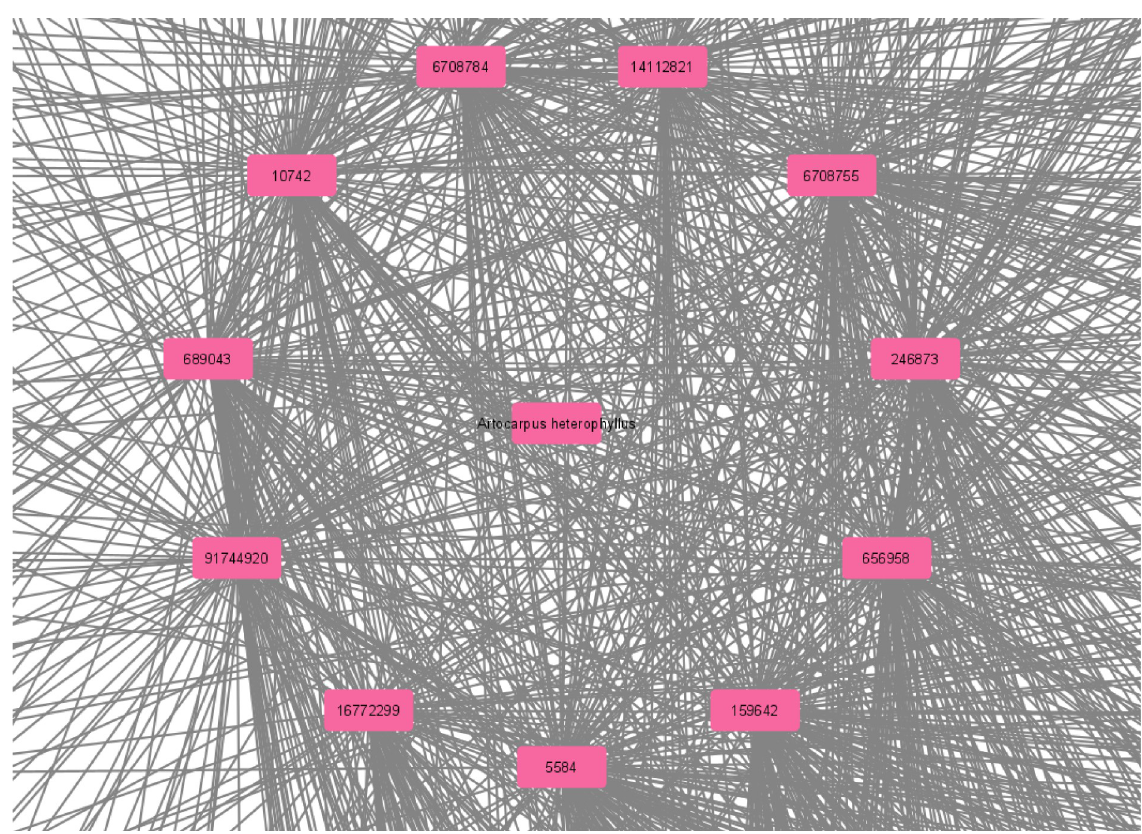
Fig 3. Identified 11 hit compound ID’s linking with the targets of obesity-linked DM. The names of the corresponding phytochemicals have been given in Table